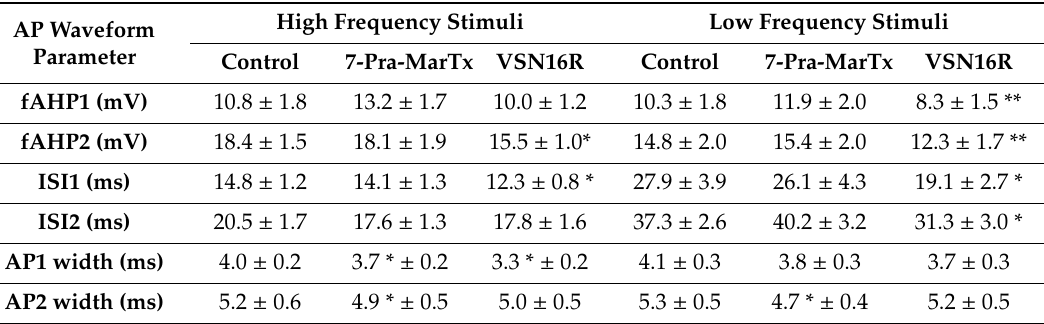
Table 3. E ff ects of 7-Pra-MarTx and subsequent application of VSN16R on AP waveform